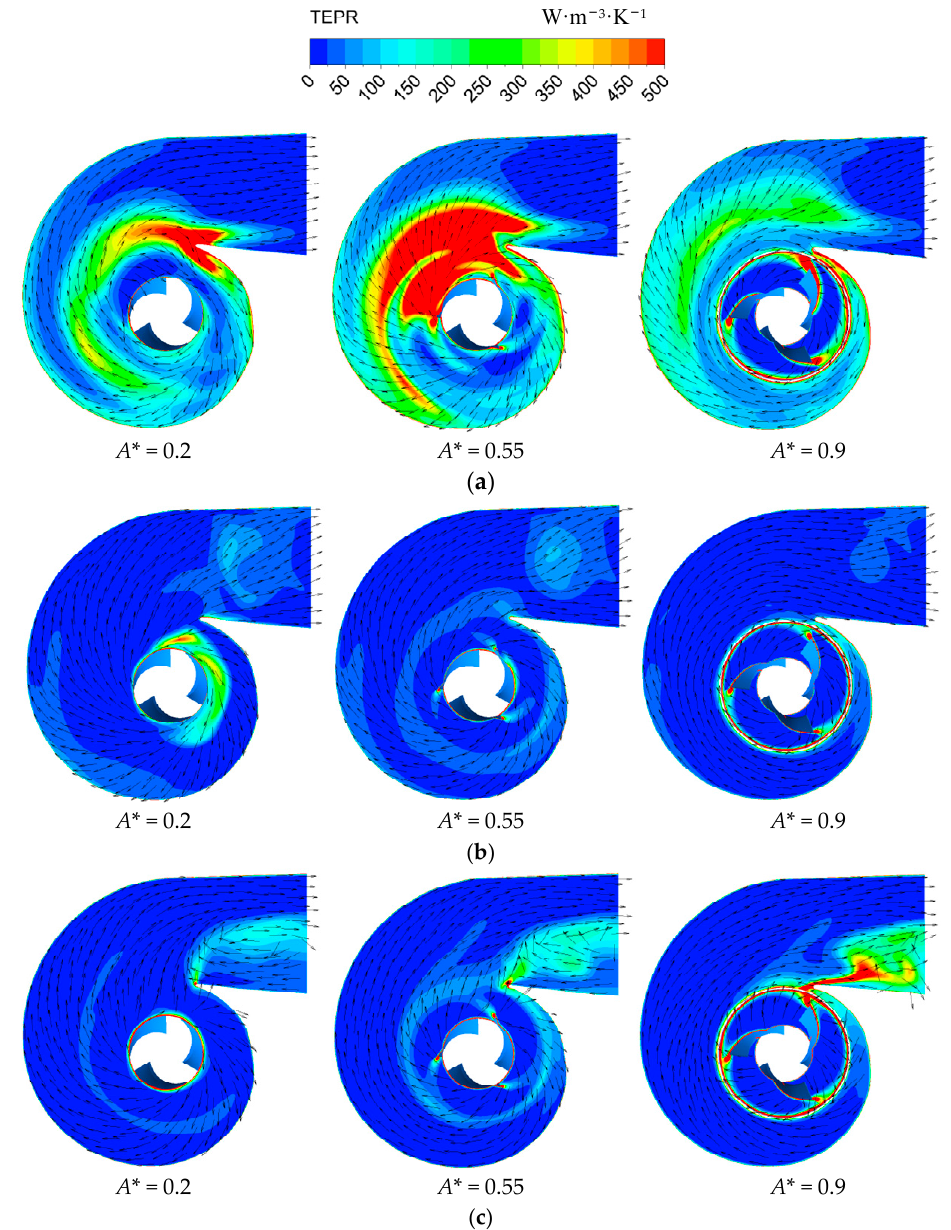
Figure 15. The distribution of TEPR and velocity in the volute at ( a ) 800 m 3 /h ( b ) 1200 m 3 /h and ( c ) 1600 m 3 /h.